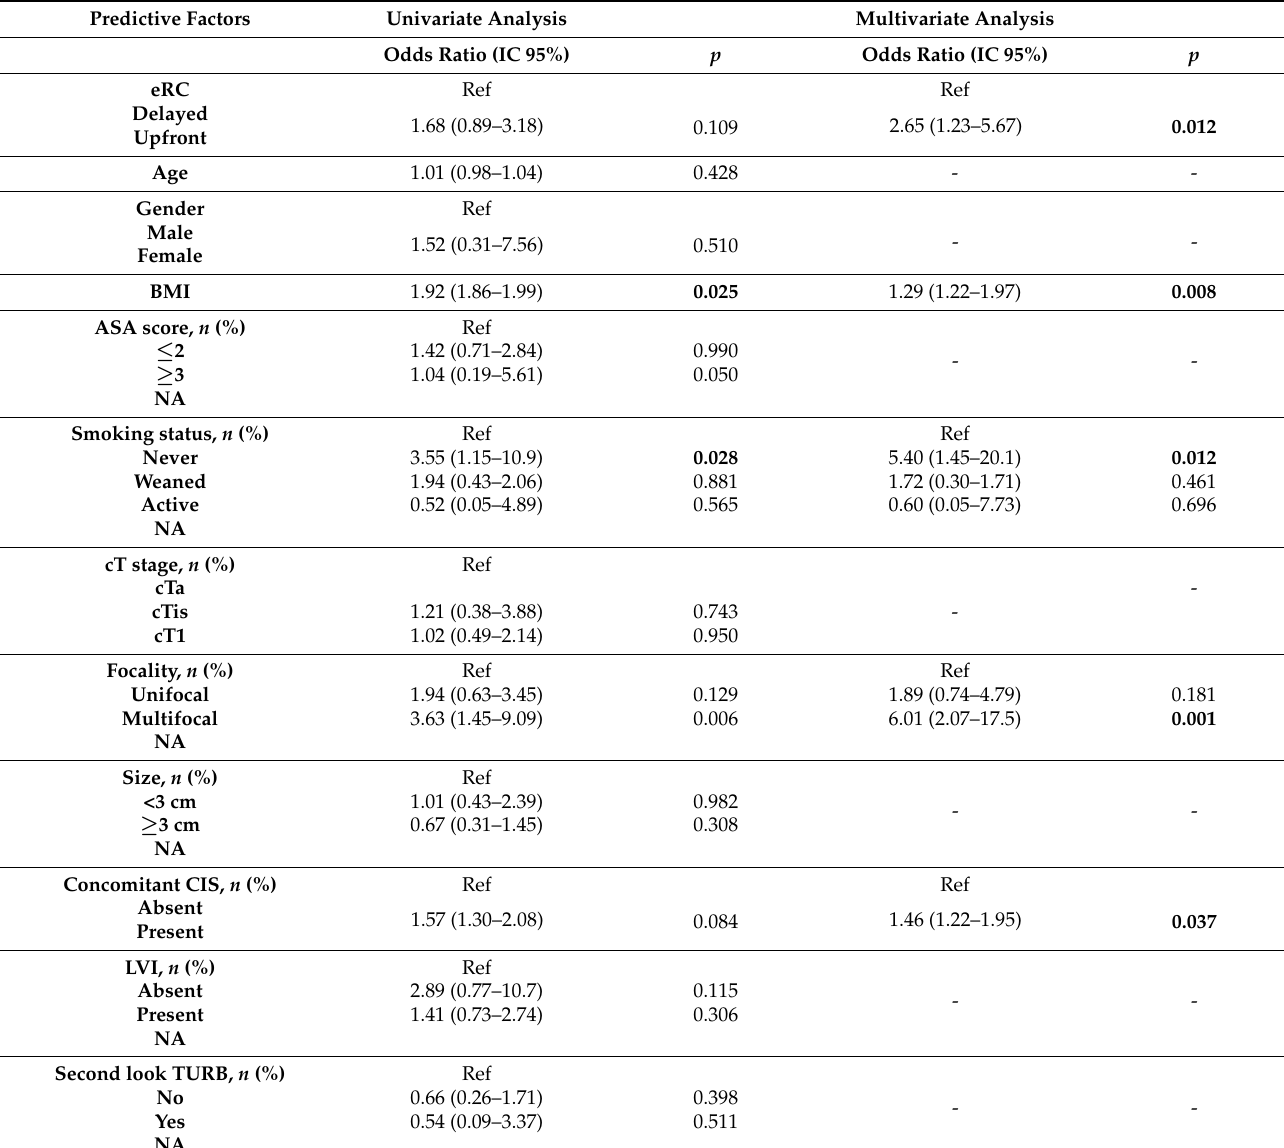
Table 6. Uni- and multivariate analysis of predictors of pathological upstaging in included patients treated with upfront or delayed eRC for HR-NMIBC. Bold: It is a significant